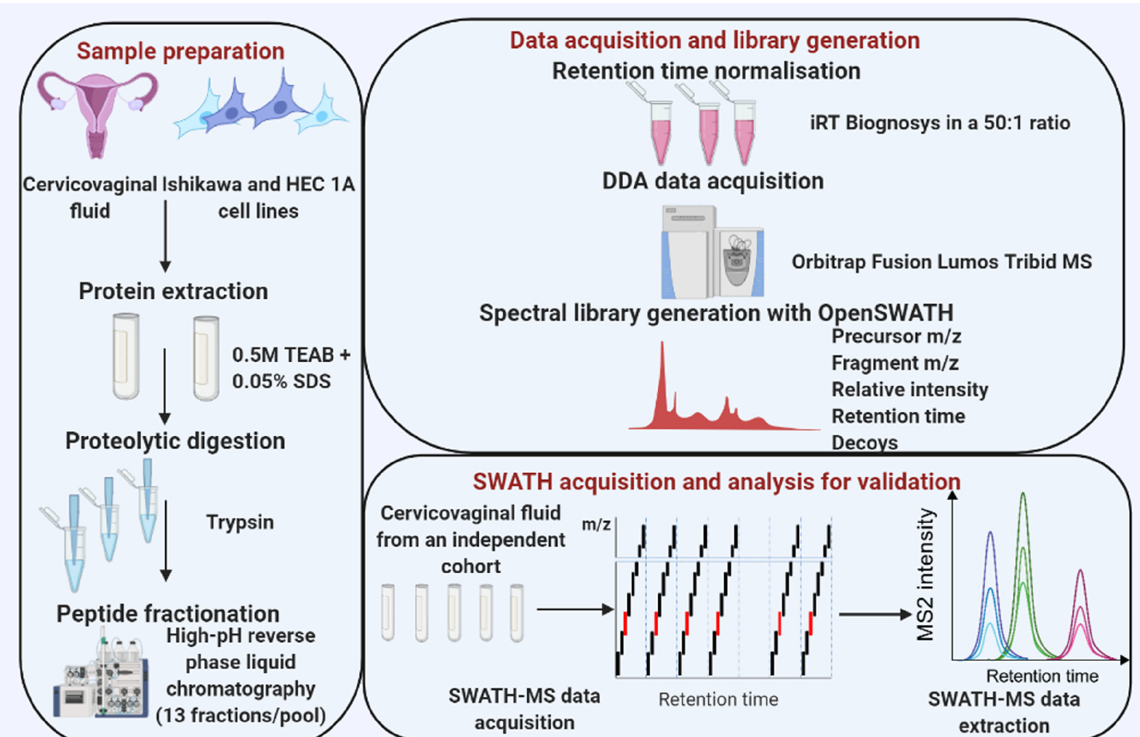
Figure 1. An overview of data acquisition and spectral library generation workflow. Data acquisition: Pooled cervico-vaginal fluid samples from 9 cancer cases, 3 AH and 7 controls were used for the library generation while two EC cell lines were used for the cell line-based library. Cervico-vaginal samples were separated into pellets and supernatants. Pellets from both cervico-vaginal fluid and EC cell lines were subjected to lysis and protein extraction. All samples were subjected to proteolytic digestion with trypsin, peptide fractionation using high-pH reverse phase liquid chromatography and LC-MS/MS analysis. Library generation: Sequence database search was done using X!Tandem while the library construction was performed using the OpenSWATH pipeline. Library validation: technical replicates of five cervico-vaginal samples were used to search the library to assess its applicability for SWATH-MS data analysis, while ten samples (five cancers and five controls) were used to assess the potential utility of the library for biomarker discovery in the real-world